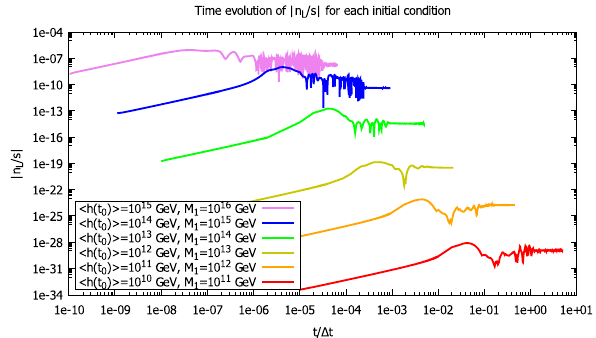
Fig. 3 Thetimeevolutionoftheabsolutevalueofthelepton-to-entropy ratio comparison with several initial conditions. The initial value of (cid:4) h ( t ) (cid:5) and the lightest right-handed neutrino mass M 0 their ratio is fixed as (cid:4) h ( t 0 ) (cid:5) / M 1 = 0 . 1. The time scale (cid:16) t is evaluated in the case of (cid:4) h ( t 0 ) (cid:5) = 10 10